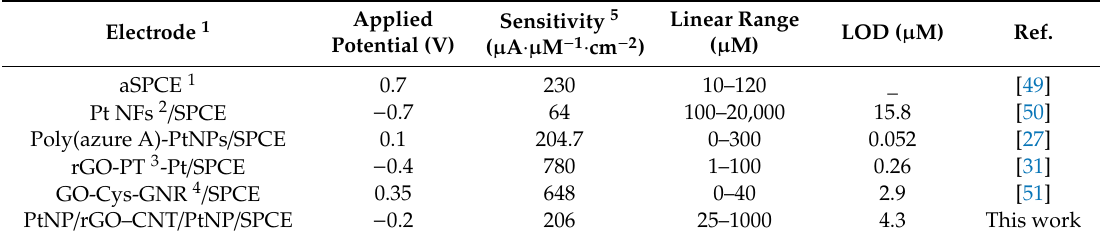
Table 1. Comparison of the analytical performance of our non-enzymatic biosensor with that of other PtNPs or GO-modified SPCEs for detection of H 2 O 2